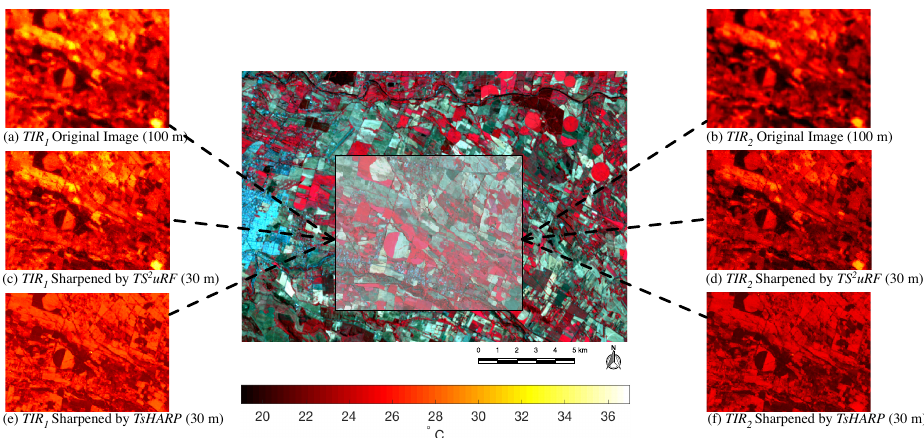
Figure 9. Visual comparison between ( a ) the original image TIR 1 and ( b ) TIR 2 at 100 m spatial resolution and sharpened TIR 1 ( c ) and TIR 2 ( d ) at 30 m by TS 2 uRF and sharpened TIR 1 ( e ) and TIR 2 ( f ) at 30 m by TsHARP, and considering a Scale 1 − 3 as a spatial context information.